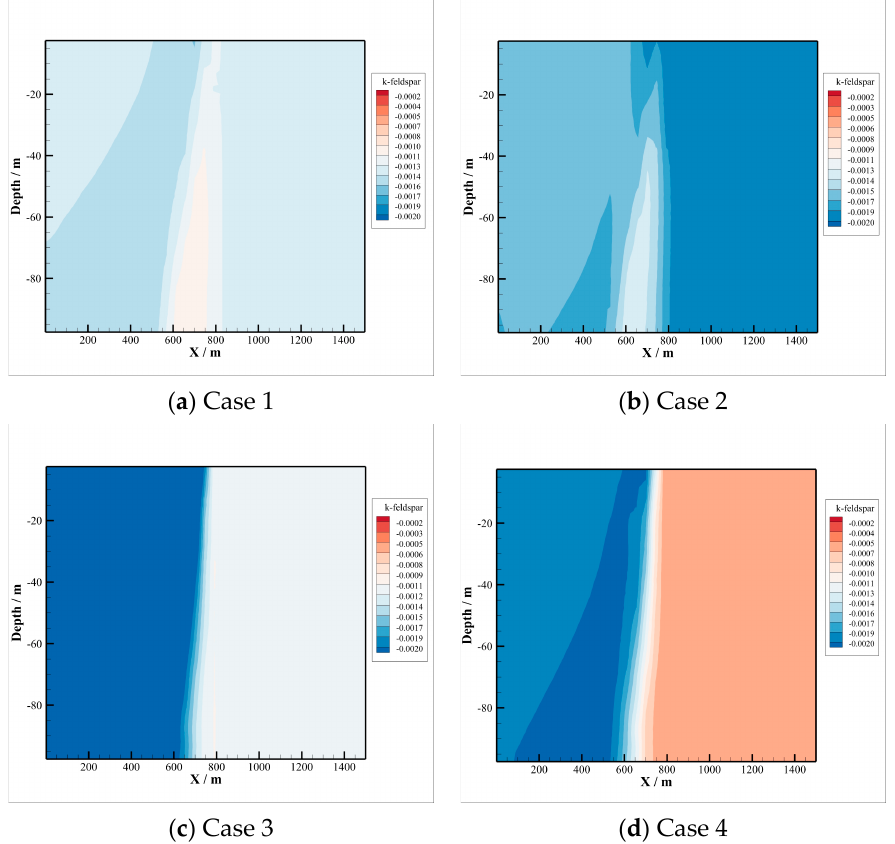
Figure 13. K-feldspar dissolution in different cases.